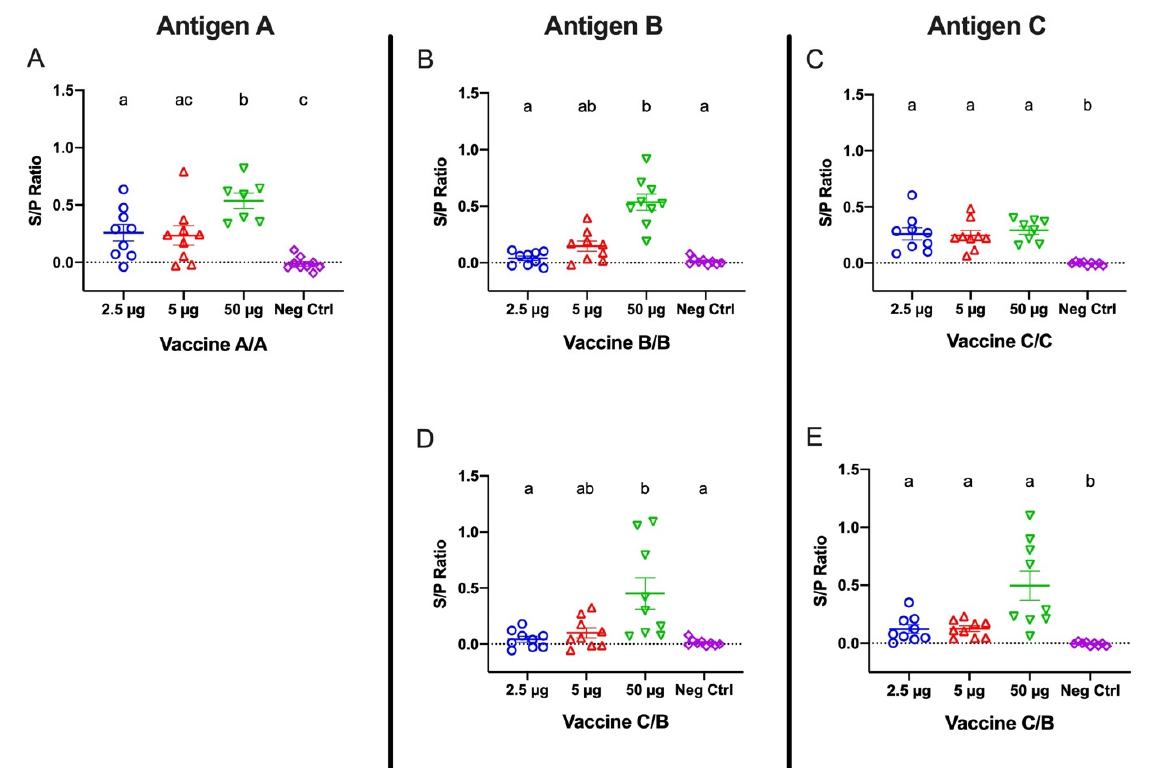
Figure 3. IgY titers from egg yolk collected six weeks following the second vaccination for groups receiving ( A ) vaccine A/A, ( B ) vaccine B/B, ( C ) vaccine C/C, and ( D , E ) vaccine C/B combinations. Hens were inoculated twelve days apart. Antigen A-, B-, and C-coated plates were used for panels ( A ), ( B , D ) and ( C , E ), respectively. Error bars indicate the mean and standard error. Means without a common letter (A–C) are significantly different ( p < 0.05).